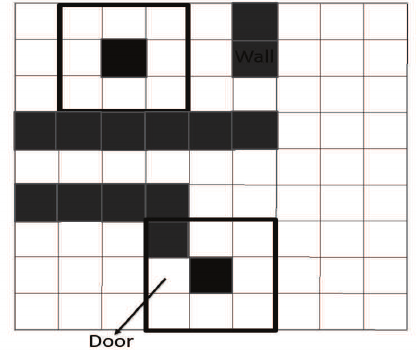
Figure 3: Neighborhood in a space and between spaces